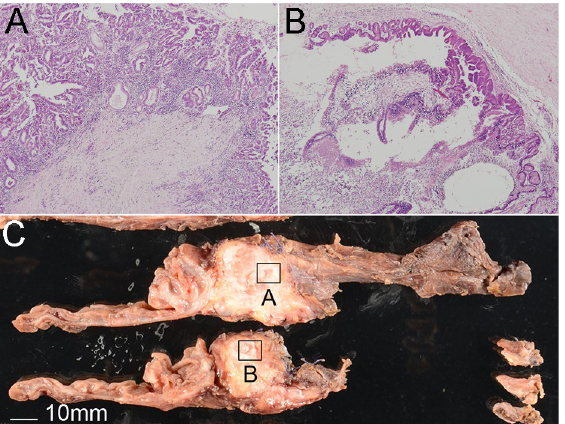
Figure 1. Representative images of the positional relationships between malignant-potential IPMN (( A ), HG-IPMN in the image) and A-IPMN ( B ) dissected regions. Original magnification, × 40. Scale bar = 10 mm. A-IPMN was defined as a benign IPMN dissected region, as close as possible to the malignant-potential IPMN (within one or two